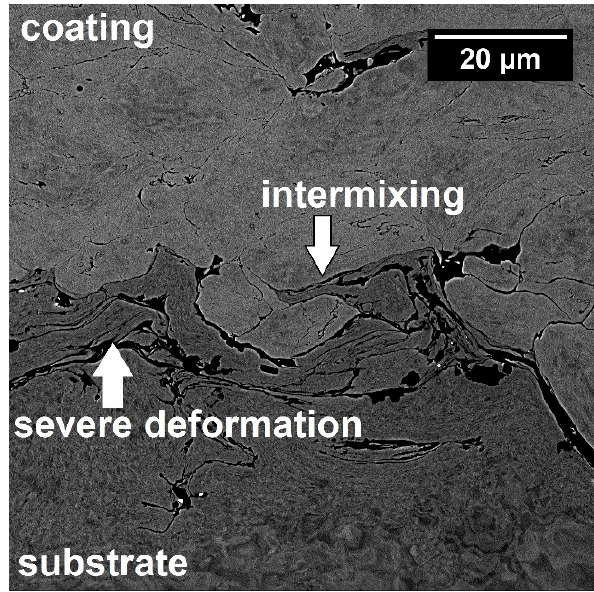
Figure 6. SEM of the interface substrate/coating of 316L-CGS_1 obtained at 3000×.